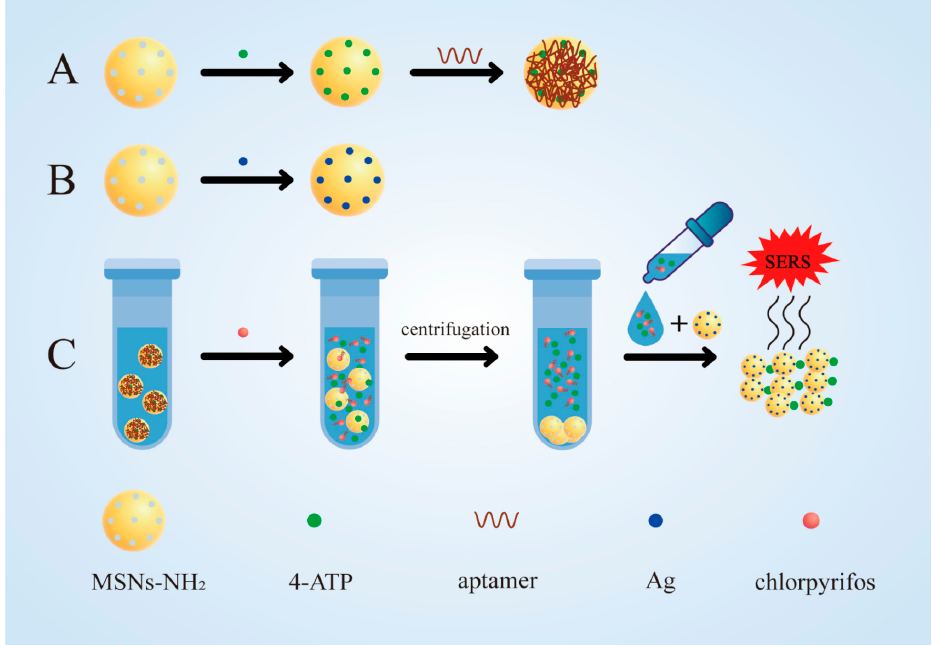
Figure 1. The synthesis of 4-ATP@MSNs-NH 2 @aptamers ( A ) and the Raman substrate Ag@MSNs ( B ); the detection process for chlorpyrifos ( C ).